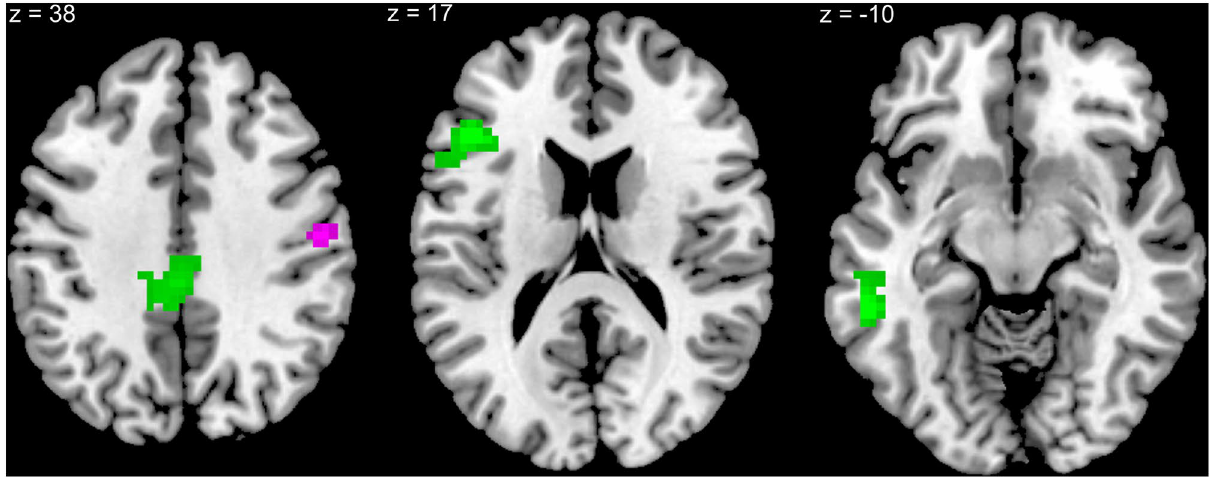
Figure 2. Activation clusters negatively associated with visual imagery score during correct recognitions (purple) and false recognitions (green) of high-frequency words, while controlling for verbal hallucination proneness score, sex, verbal IQ, and Pr-global. The slices depicting MNI coordinates derive from peak activations for the high-frequency word contrasts reported in Tables 1 and 2.